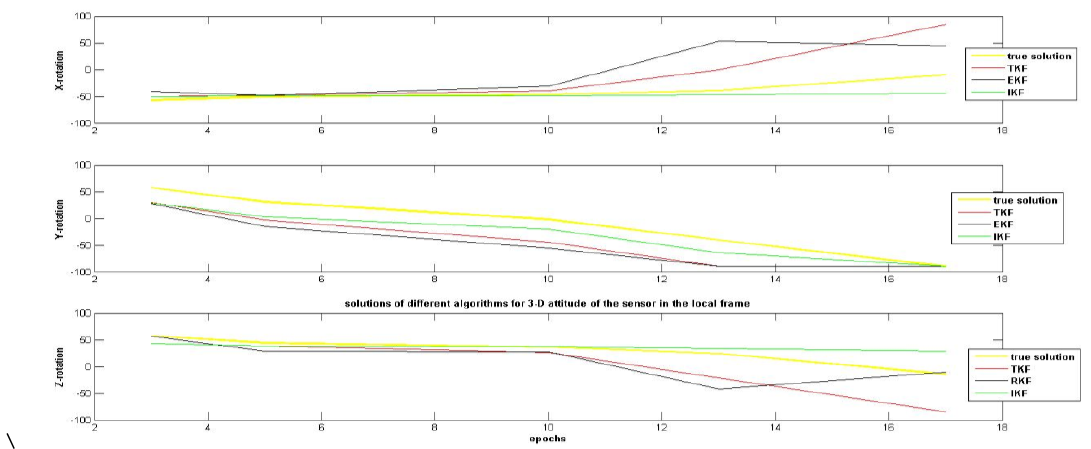
Figure 6: solutions of different algorithms for 3-D attitude of the mobile sensor in a local